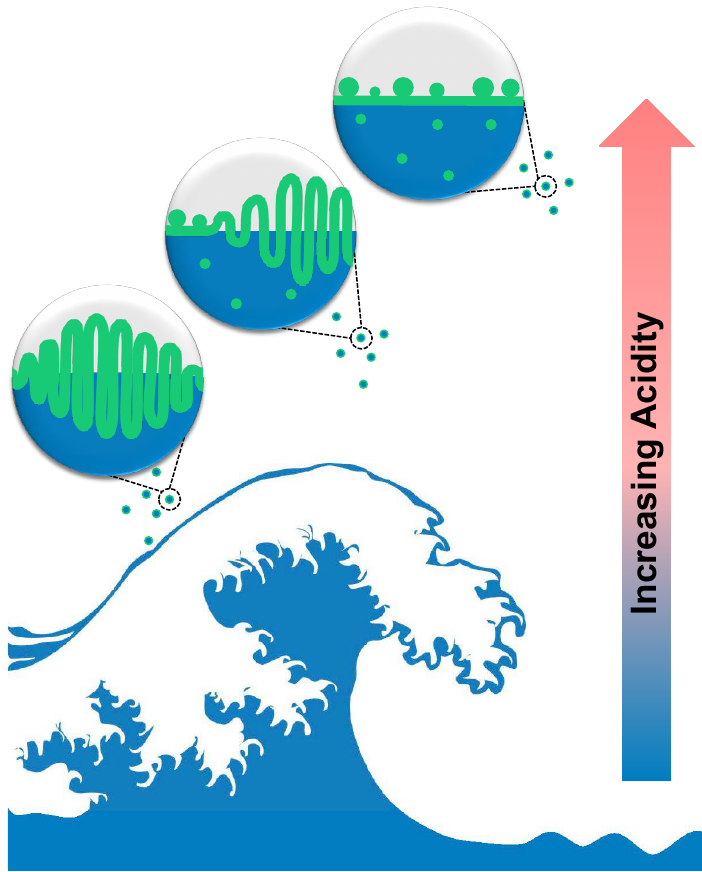
Figure 6. Illustration of the proposed SSA proxy film collapse mechanisms throughout particle residence in the marine boundary layer (MBL). Increased acidity is associated with longer aging in the MBL. The light gray circles correspond to zoomed-in schematics of the collapsed SSA proxy film. Nascent SSA films (bottom circle) fold at collapse. Upon subphase acidification (middle circle), the collapsed film folds and forms 3D nuclei simultaneously. After a significant amount of aging (top circle), the film no longer folds and only forms 3D nuclei at collapse (see Supplementary